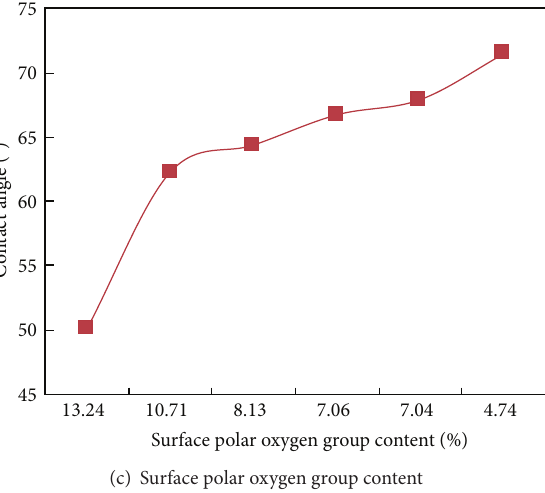
Figure 3: Curves of the relationship between oxygen contents and contact angles before and after